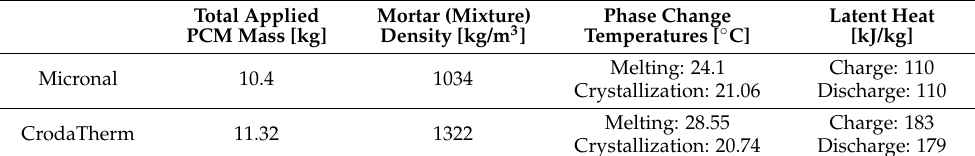
Table 1. Thermo-physical properties of the two PCMs used into the applied mortars.